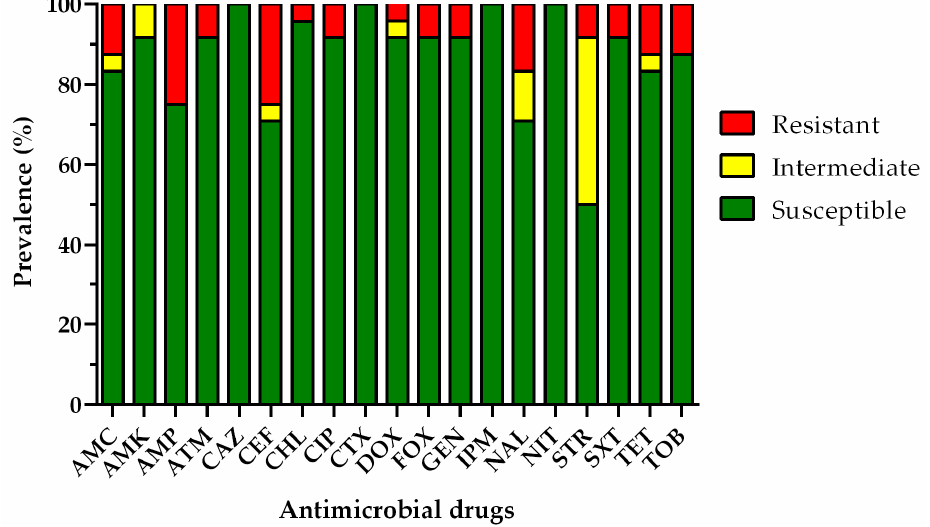
Figure 3. Percentage of resistance in E. coli isolated from the farming water and the edible portion of